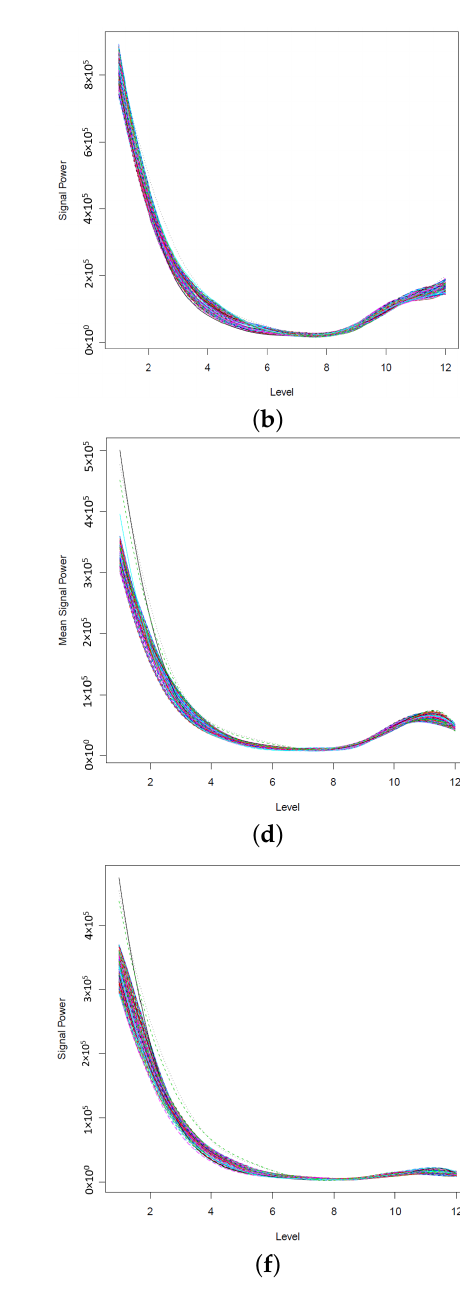
Figure 7. The plots of functional wavelet power spectra for six channels long term interictal signal of patient 1. The maximum number of B-splines basis functions are used to smooth the sample wavelet power spectra, i.e., K = 10. ( a ) Channel 1, ( b ) Channel 2, ( c ) Channel 3, ( d ) Channel 4, ( e ) Channel 5, ( f ) Channel